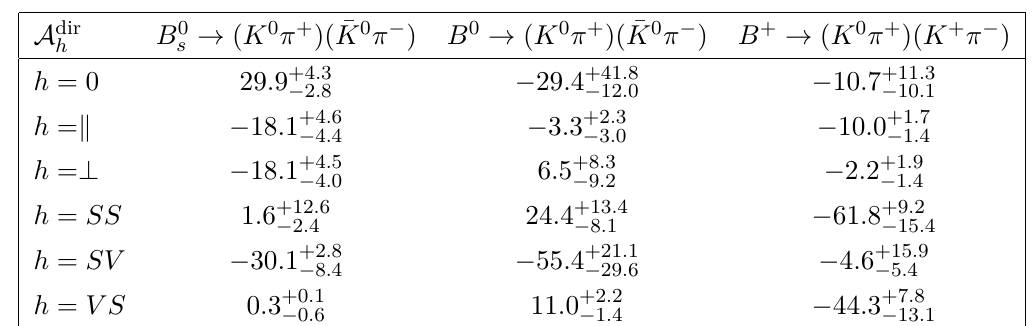
Table 5 . PQCD predictions for the direct CP asymmetries ( % ) of the considered decays in the Kπ invariant mass window of 150 MeV around the K ∗ (892)